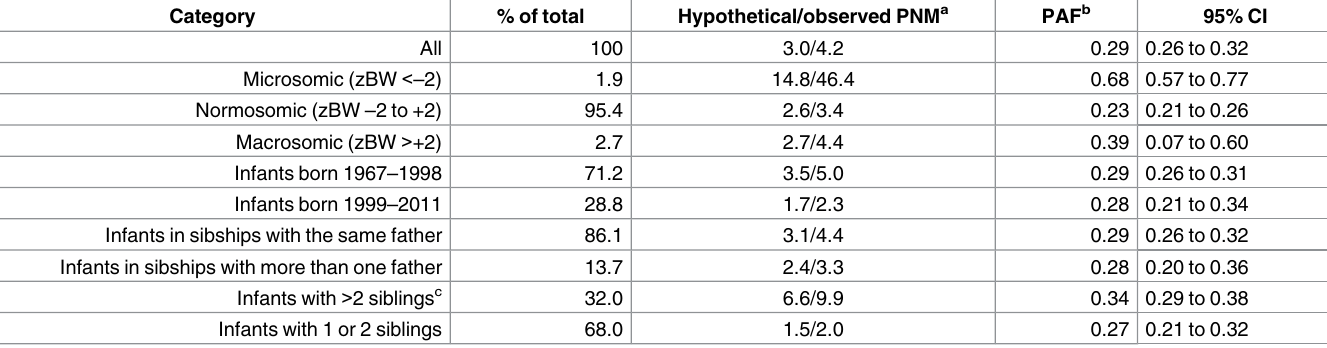
Table 5. Population fraction of perinatal deaths attributed to deviance from mean sibling birth weight, according to zBW category and selected population subsets: Norway 1967–2011. Category